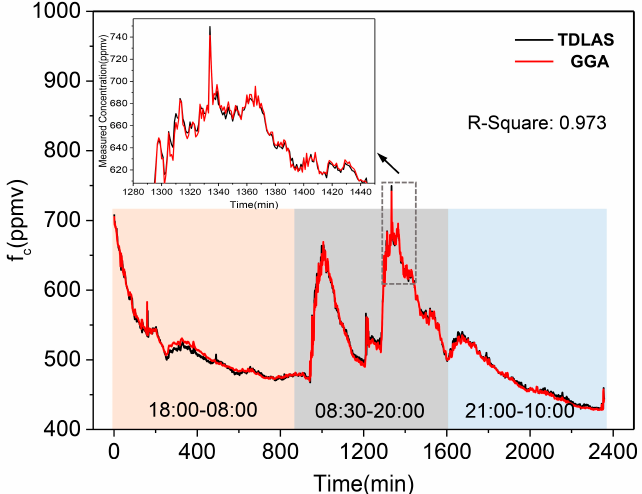
Figure 8. Comparison measurement of ambient CO 2 in the laboratory between the TDLAS system (black curve) and GGA (red curve). The inset is a detailed plot of a concentration mutation.